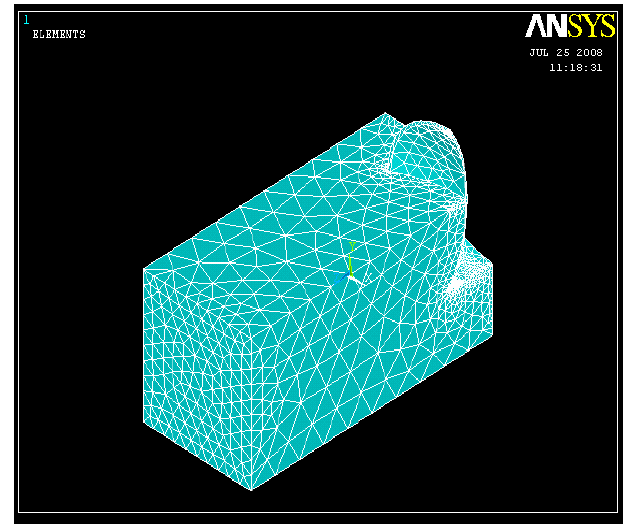
Figure 3. Mesh of the soil and harrow disc model (half symmetry).